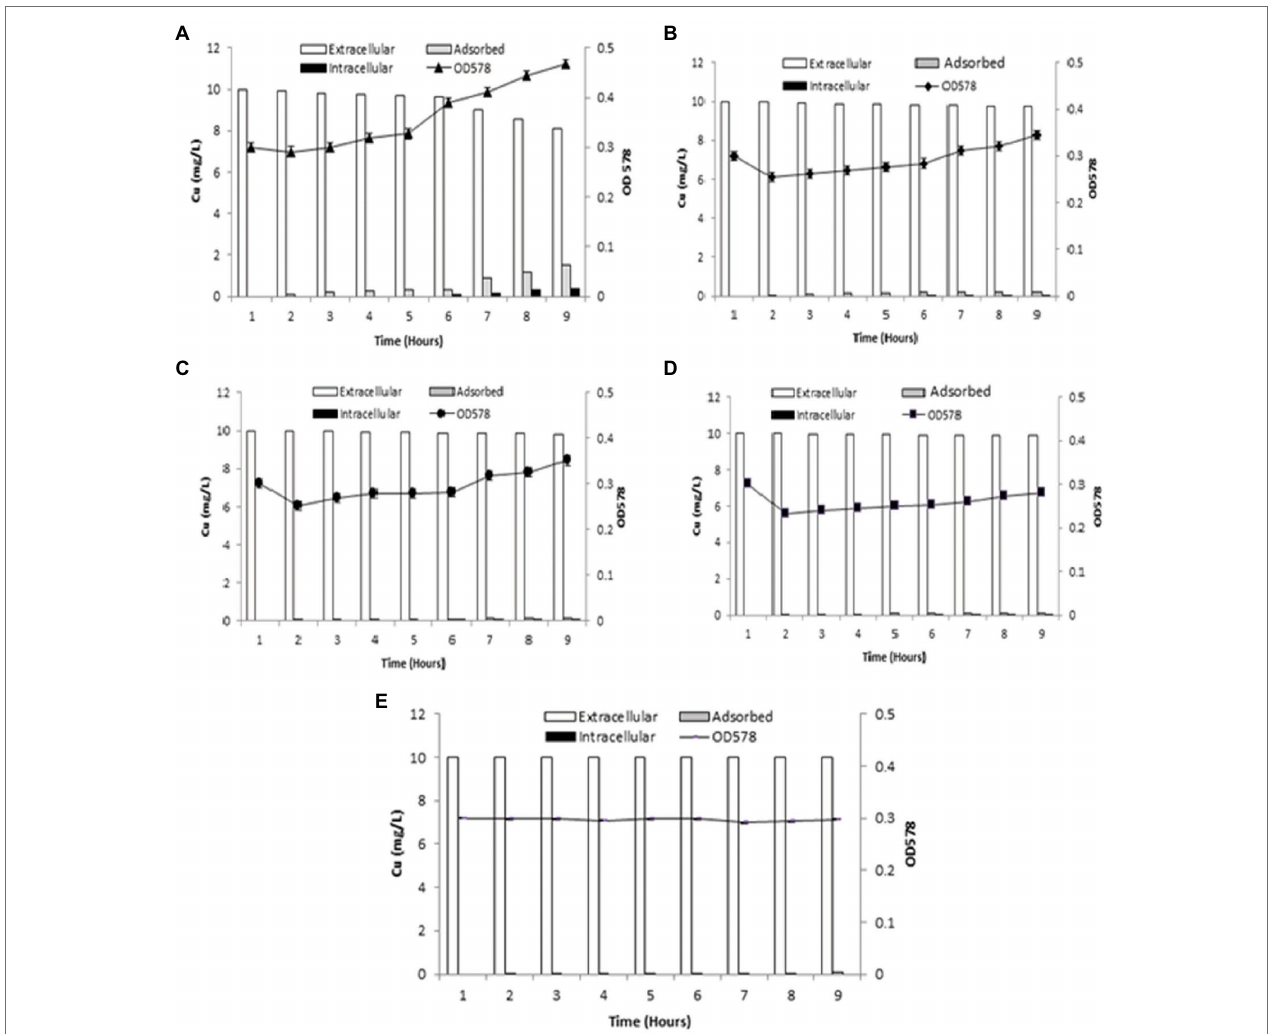
FIGURE 3 | Graphs demonstrating biosorption by B. altitudinis MT422188 (A) for Cu (10 mg/l; B ) for Cu (10 mg/l) and DNP (1 mm; C ) for Cu (10 mg/l) and DCCD (100 μ m; D ) for Cu (10 mg/l), DNP (1 mm) and DCCD (100 μ m; E ) for dead cells and Cu (10